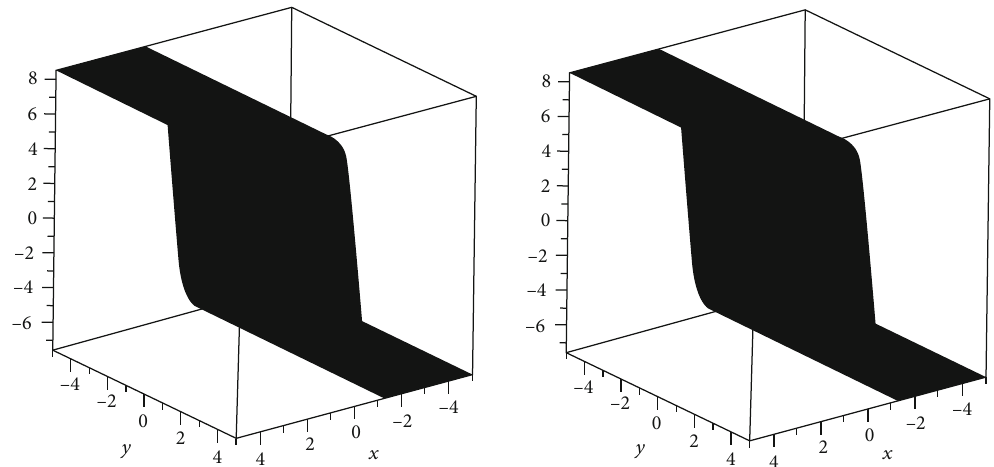
Figure 1: Graphical view of the exact and analytical solution for J ð ζ , ρ Þ at δ = 1 of system 1 .